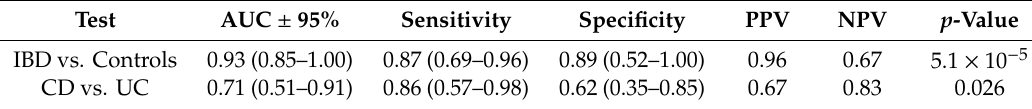
Figure 7. IBD analysis: Wolf eNose ROC curves; IBD vs. Controls ( left ); CD vs. UC ( right ). Table 4. IBD analysis: G.A.S. BreathSpec GC-IMS results.